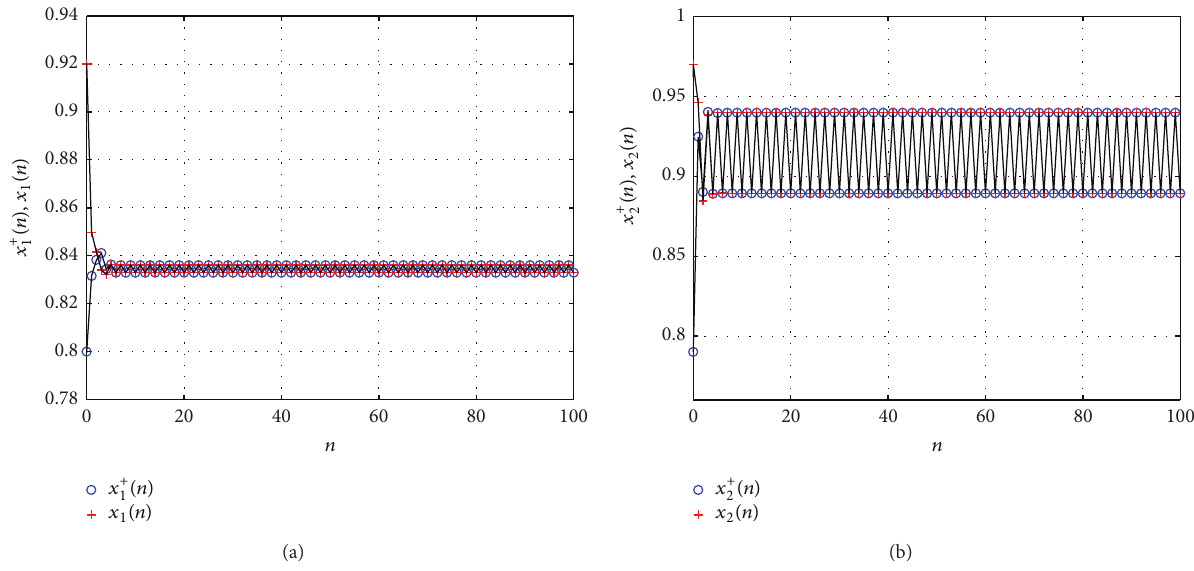
(−2) = 0.85 , 𝑥 + (−1) = 0.80 , and 2 2